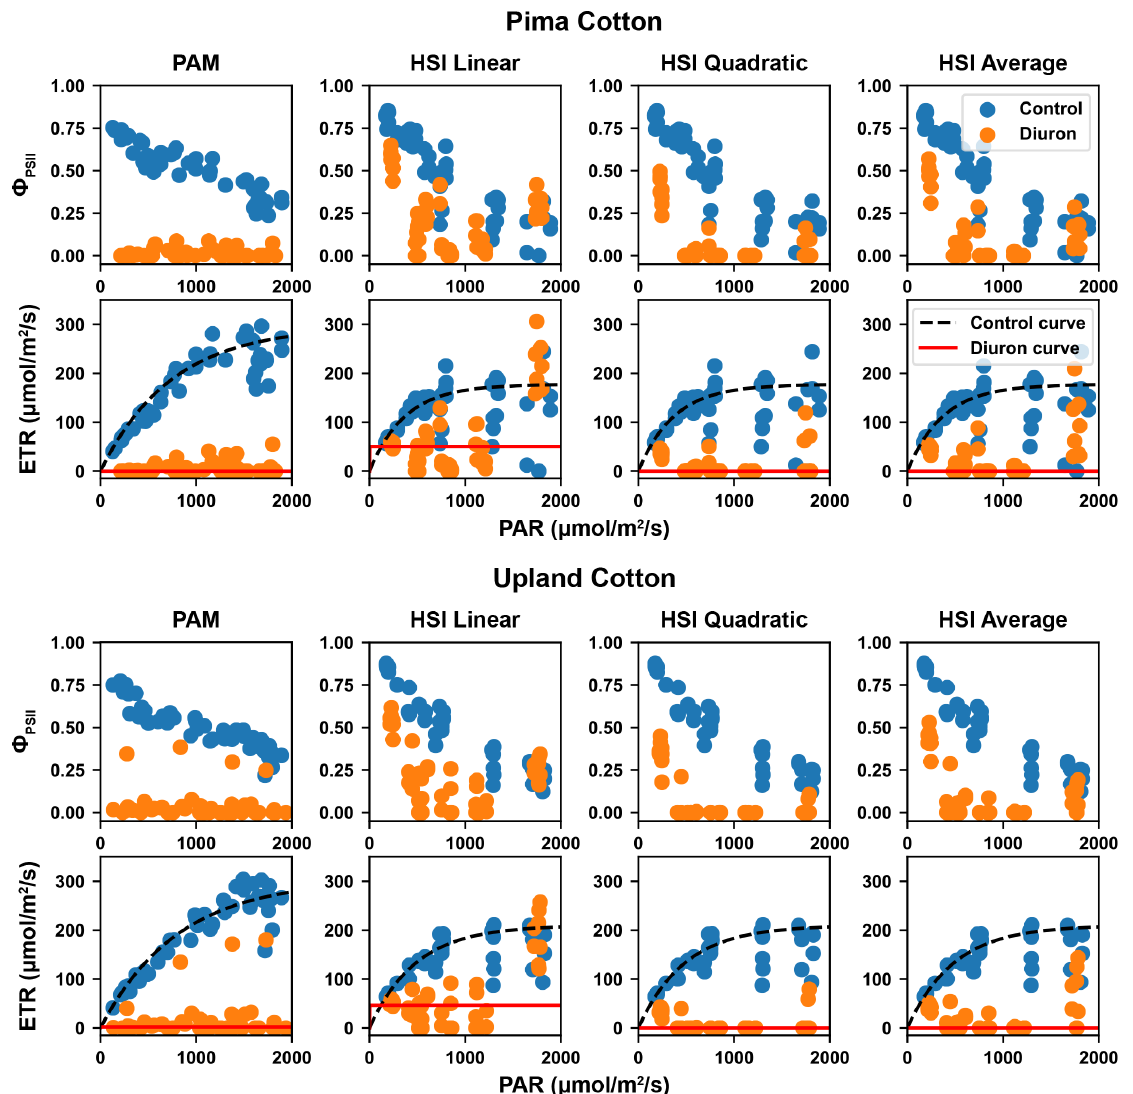
Figure 5. Calculated effective quantum yield of PSII ( φ PSII ) and electron transport rate (ETR) for the two genotypes under control and Diuron treatments. PAR is short for photosynthetically active